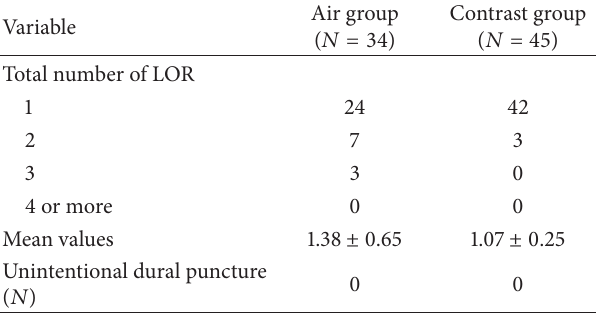
Table 2: Total number of LOR procedures and unintentional dural punctures.